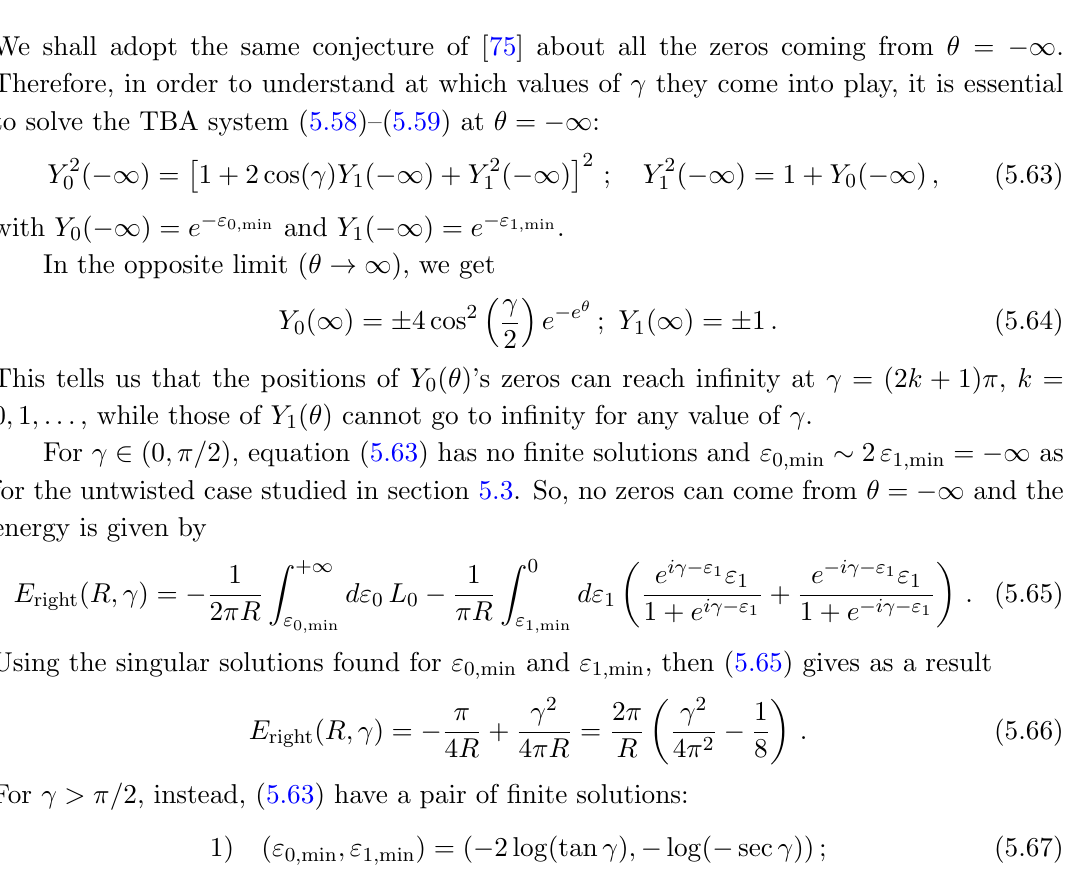
Figure 4 . Finite solutions chosen for Y 0 ( (cid:0)1 ) and Y 1 ( (cid:0)1 ) from equations (5.63), and the solution chosen for Y 0 ( 1 ) from (5.64), in the interval (cid:13) 2 (0 ; 4 (cid:25)